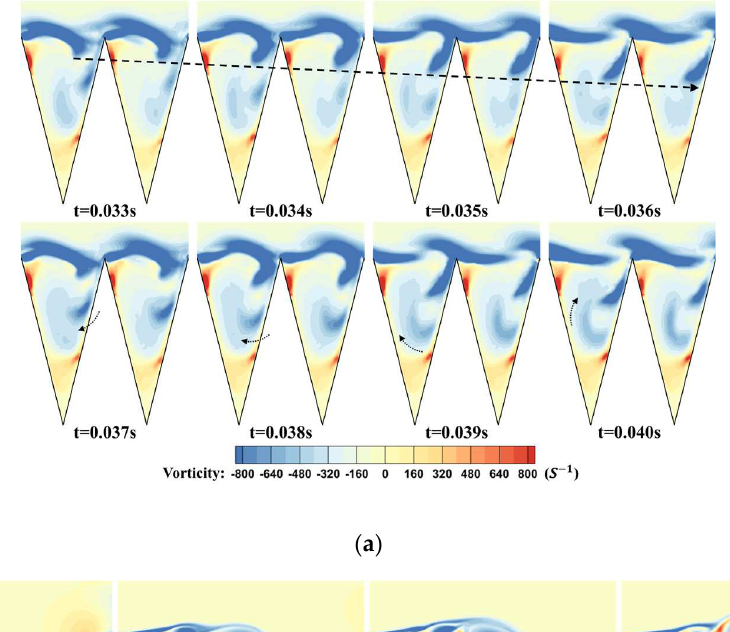
. ( a ) Identifi- , and ( b ) (cid:145) (cid:21)* . (cid:145) o# j 80 (cid:145) o# j 540